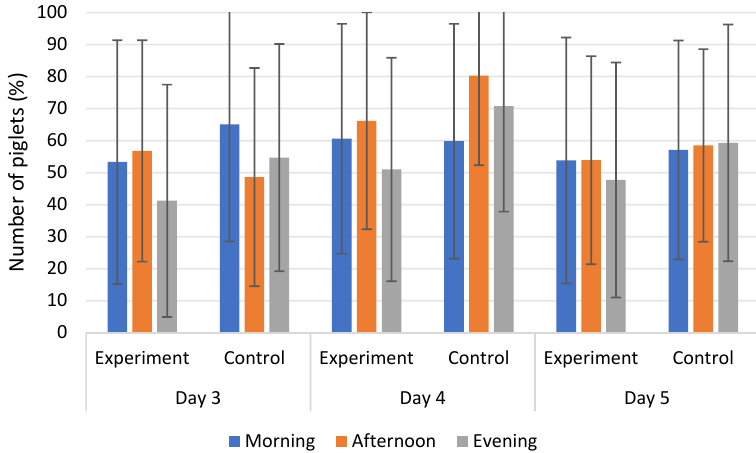
Figure 4. Mean percentage of lying piglets per litter in the experimental and control groups in the morning (6.00–10.00), in the afternoon (13.00–17.00), and in the evening (19.00–21.00). Day 4 = day of vaccination.